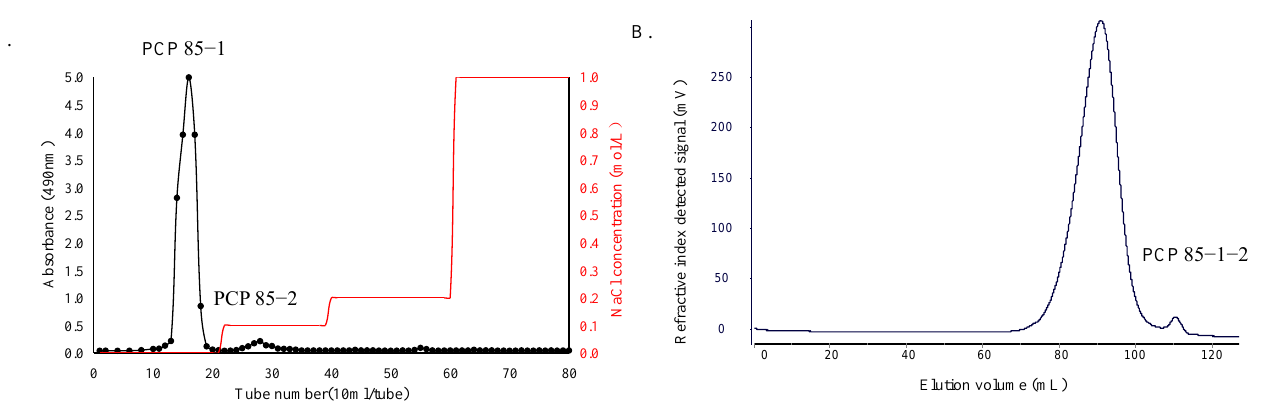
Figure 2. ( A ) Stepwise elution curve of crude PCP 85 on DEAE-Sepharose Fast Flow cellulose column. ( B ) Stepwise elution curve of PCP − 85 − 1 on Superdex 75 pg column. Figure 3. ( A ) The HPGPC-RID profiles of PCP 85 − 1 − 1; ( B ) HPLC-RID chromatograms of standard monosaccharide mixture and hydrolysis products of PCP 85 − 1 − 1. 2.4. FT-IR Spectra Characteristics of PCP 85 − 1 − 1 The FT-IR spectra of the polysaccharide sample are shown in Figure 4. The broad and intense absorption peak around 3310.69 cm −1 was attributed to the O – H stretching vibra- tion [31], showing that there was a strong intermolecular force in the structure of the pol- ysaccharides. The weak bands near 2934.14 cm −1 and 2884.30 cm −1 were assigned to the C – H stretching vibration. The absorption peak near 1643.89 cm −1 was the stretching vibration